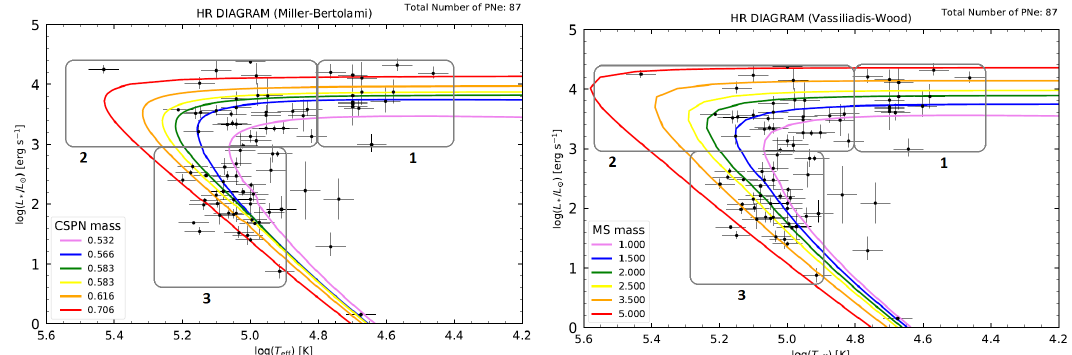
Figure 4. Central Stars location in the HR diagram, together with the evolutionary tracks by Miller Bertolami ( left ) and Vassiliadis-Wood ( right ). Note that the left panel shows CSPN masses, while the ) > 3.0 and log ( T ) < 4.8; Region right panel shows Main Sequence (MS) star masses. Region 1: log ( L ef f L (cid:12) ) > 3.0 and log ( T ) > 4.8; Region 3: log ( L ) < 3.0 and log ( T ) > 4.9. 2: log ( L ef f ef f L (cid:12) L (cid:12) Table 1. Mean values of different parameters in three regions of the HR diagram, together with their dispersion values, in brackets. Parameter Region 1 Region 2 Region 3 Number of